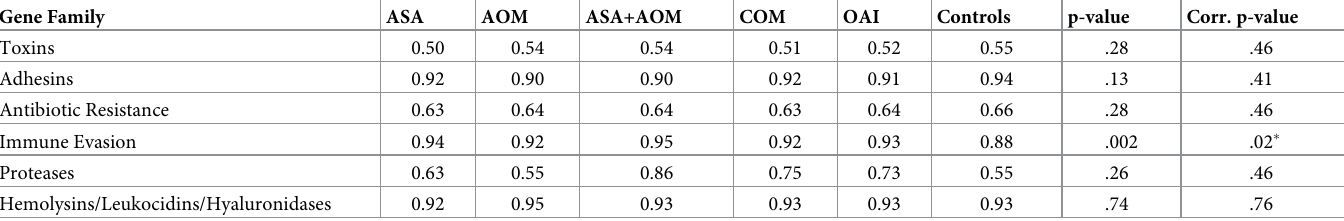
Table 2. Distribution of virulence gene families amongst Staphylococcus aureus isolates from children with osteoarticular infections compared with healthy controls. Gene Family